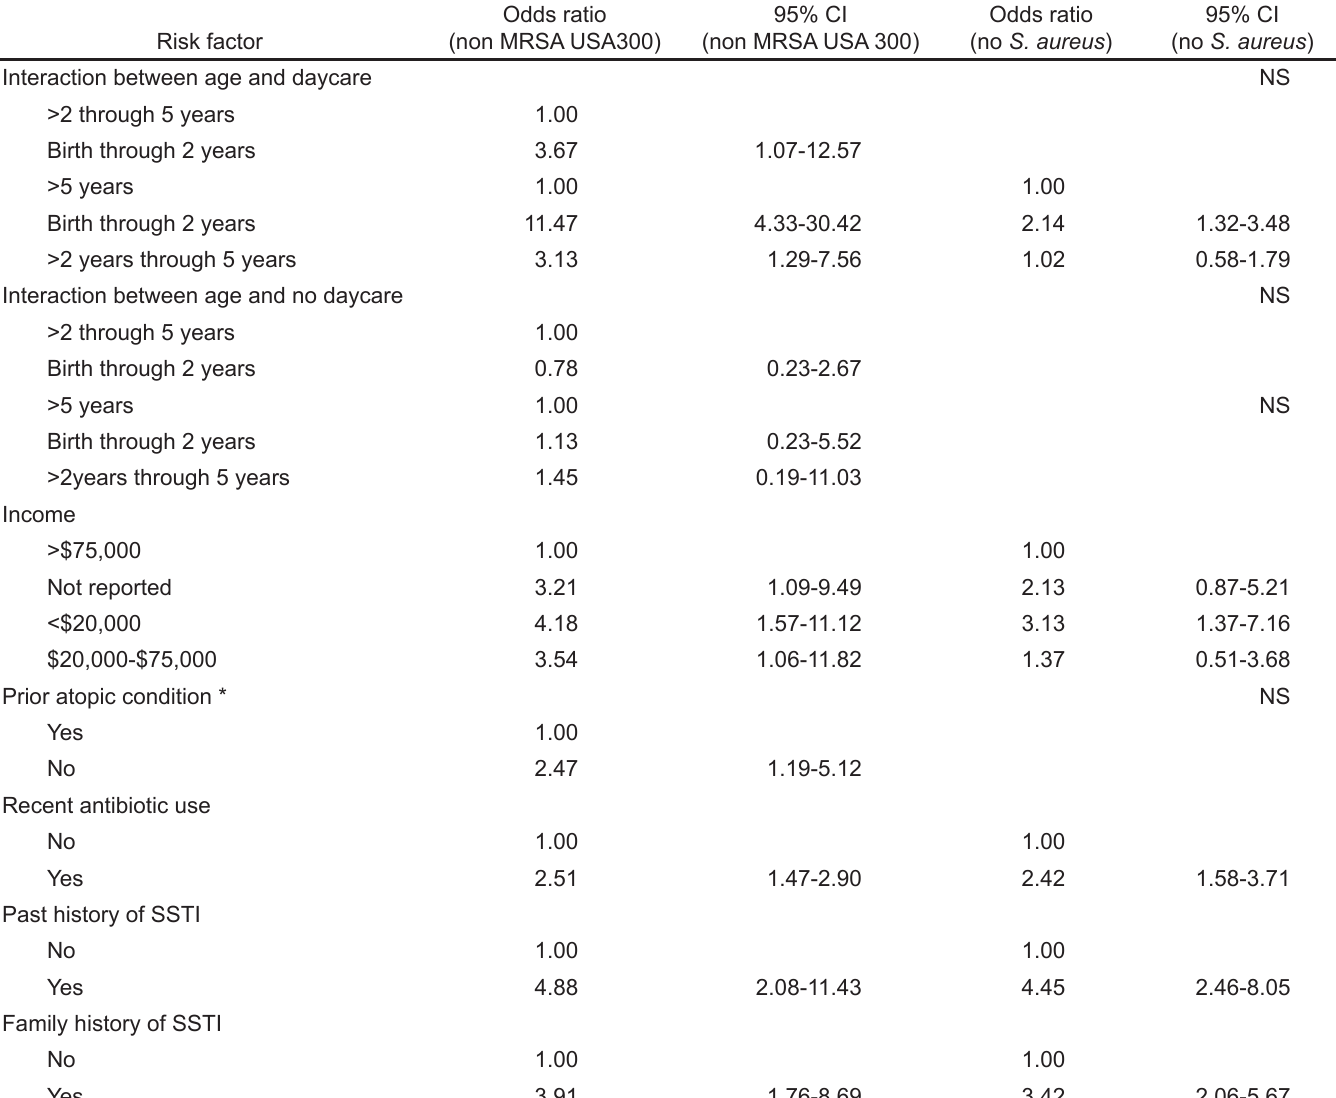
Table 2. Multivariate logistic regression analysis of risk factors associated with MRSA USA300, Non-MRSA USA300 carriage, and no S. aureus